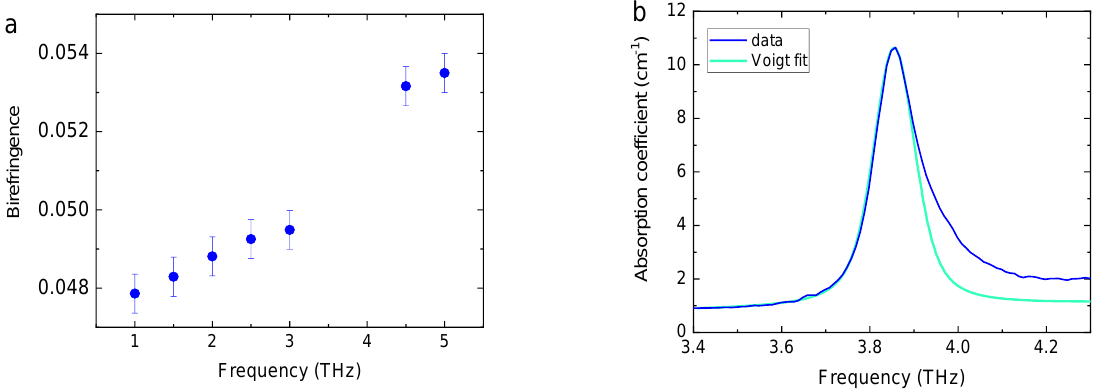
Figure 4. ( a ) Birefringence of quartz, defined as n e — n o . ( b ) Voigt fit to the phonon resonance peak at 3.855 ± 0.005 THz. The well-known optical phonon resonance [3,8,11] in the ordinary ray spectrum is seen to be at 3.855 ± 0.005 THz. The absorption maximum is 10.7 ± 0.1 cm − 1 , and the peak FWHM (full width at half-maximum) is 145 ± 5 GHz. Figure 4b shows a Voigt fit to the absorption peak. The Voigt function accounts for the broadening that may arise due to the presence of crystal defects. It is seen that the peak is asymmetric: whereas on the low-frequency side the fit is good, on the high-frequency side there is an additional broad wing, caused by the rising edge of the strong optical phonon at 11.8 THz.